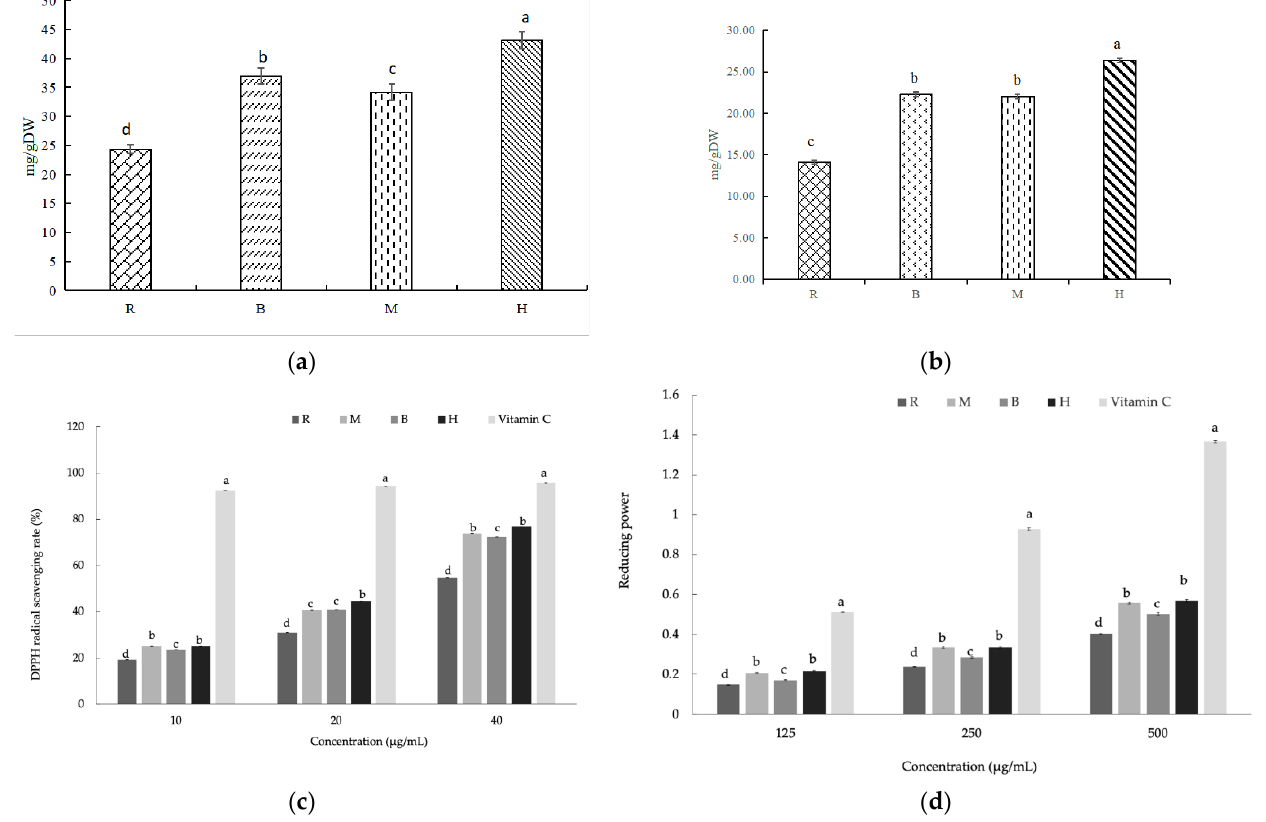
Figure 4. Functional components content and antioxidant activity of roasted Euryale ferox seed (EFS) flour. ( a ) Total phenolics content (TPC), ( b ) flavonoid content (TFC), ( c ) reducing power, and ( d ) DPPH free radical scavenging rate (%). R: Raw; M: Microwave; B: Baking; H: Industrial infrared heating-assisted fluidized bed (IHFH). Different lowercase letters represent significant differences ( p < 0.05).